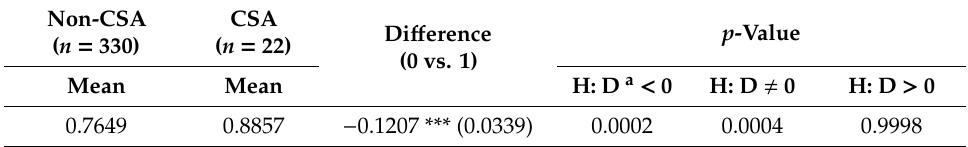
Table 6. Di ff erence test of means in technical e ffi ciency by CSA